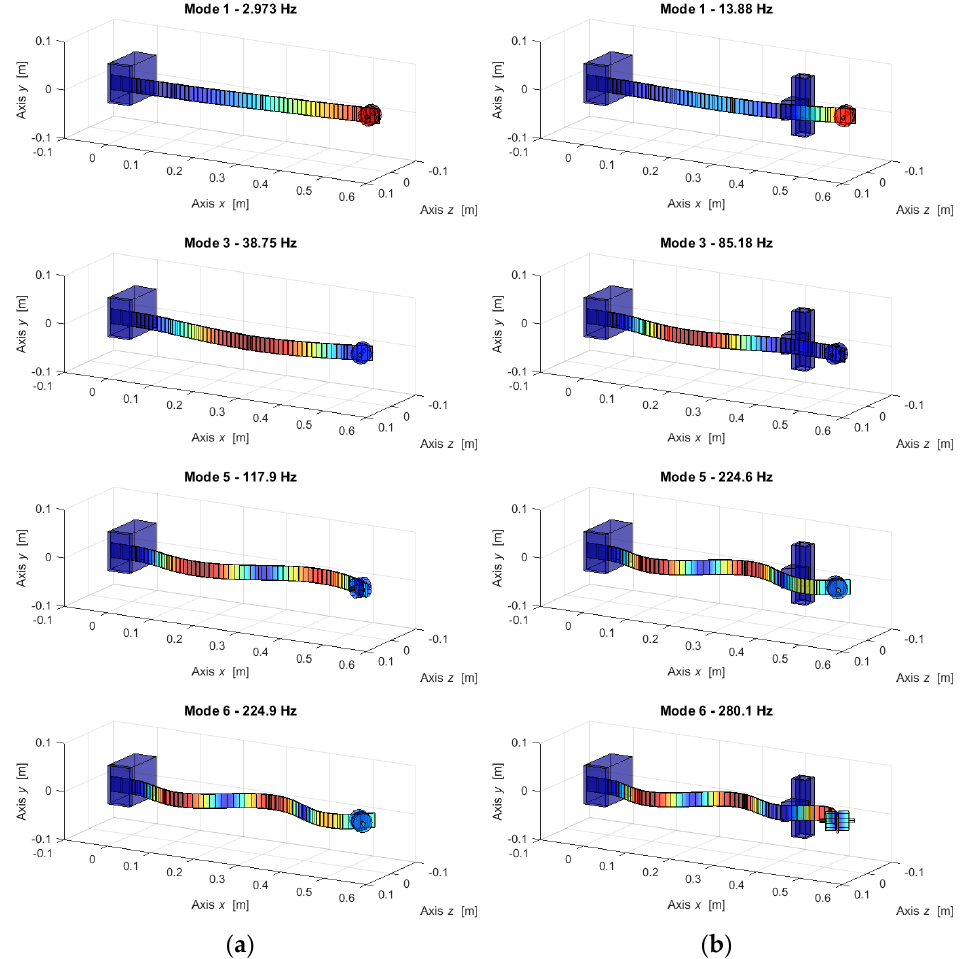
Figure 21. Bending mode shapes for clamped-free beam ( a ) and clamped-pinned-free beam ( b ) with colour scale, from blue to red, related to the displacement field.